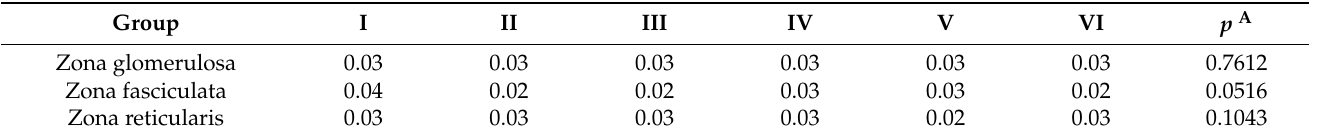
Table 1. The contribution of lipid droplets to the total selected area within the different layers of the cortex.